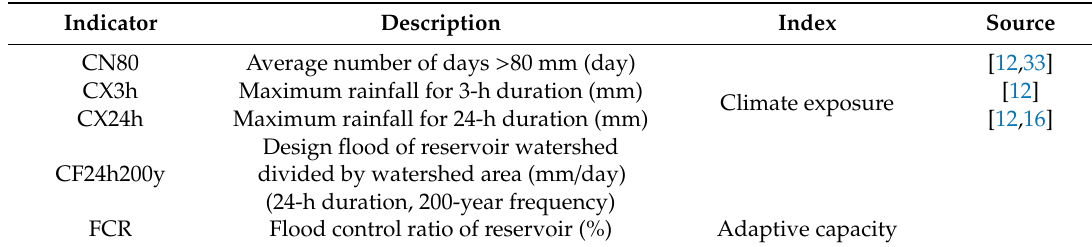
Table 1. Indicators for climate exposure and adaptive capacity.